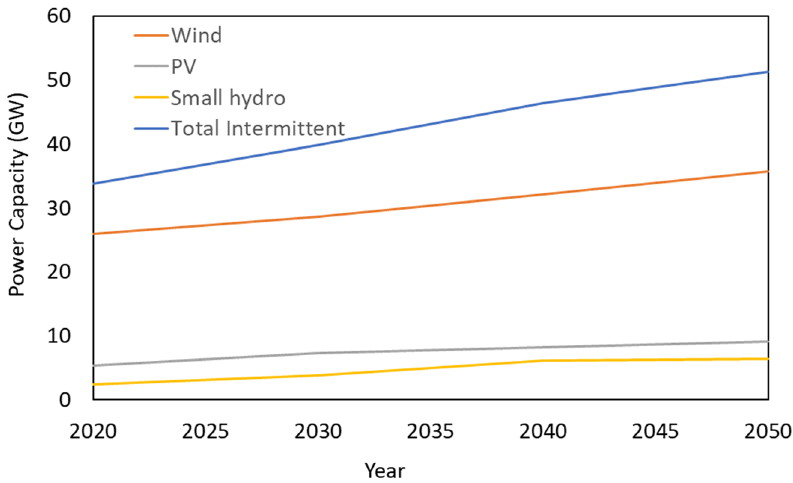
Figure 1. Estimated power capacity of intermittent energy sources in Spain for the period 2020–2050 with an energy demand growth rate of 1.36%.